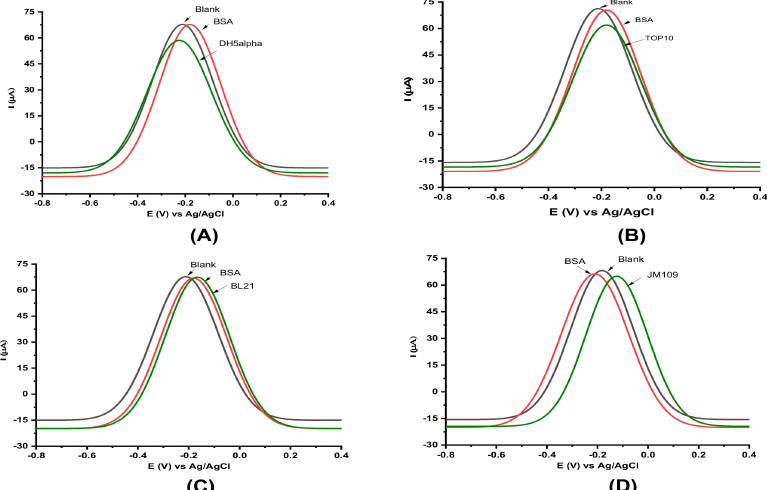
Figure 5. Specificity studies of the sensor using four laboratory E. coli strains. ( A ) DH5 α , ( B ) TOP10, ( C ) BL21, and ( D ) JM109. Black lines are the baseline-corrected SWV before incubating with the bacteria sample. Red lines for 1% of the BSA solution as an unspecific binding. Green lines for each graph are the result after incubation with the specific E. coli strain. Experimental conditions were conducted as the same conditions described in this study.